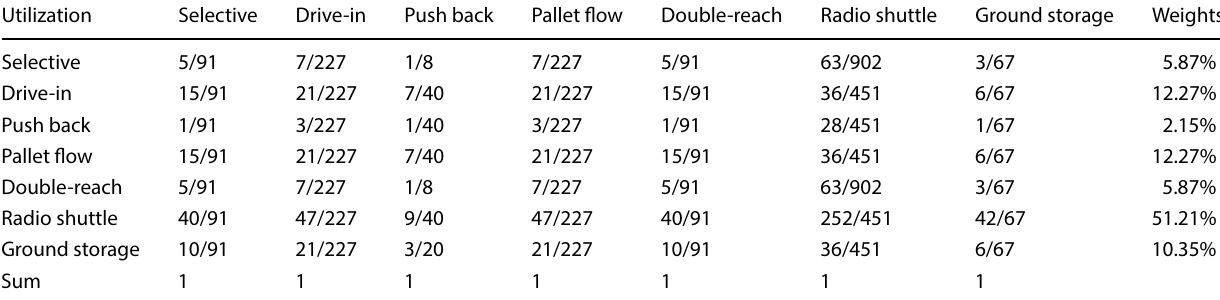
Table 11 Normalized matrix for the utilization criterion